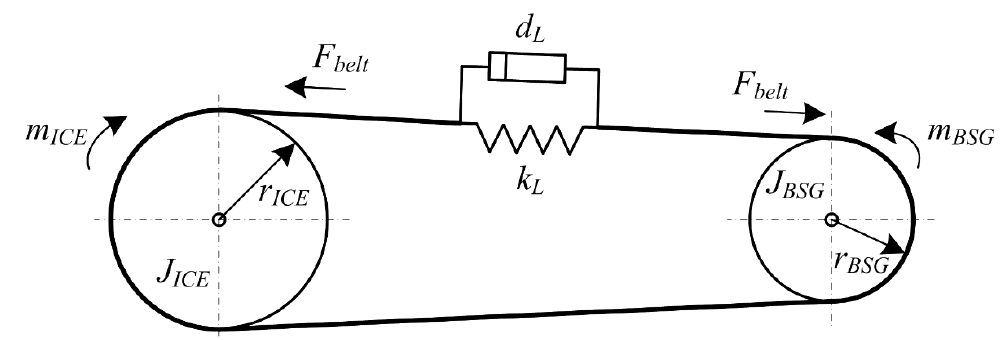
Figure 5. Multi-mass model and two-mass elastic model approximation of FEAD [10].